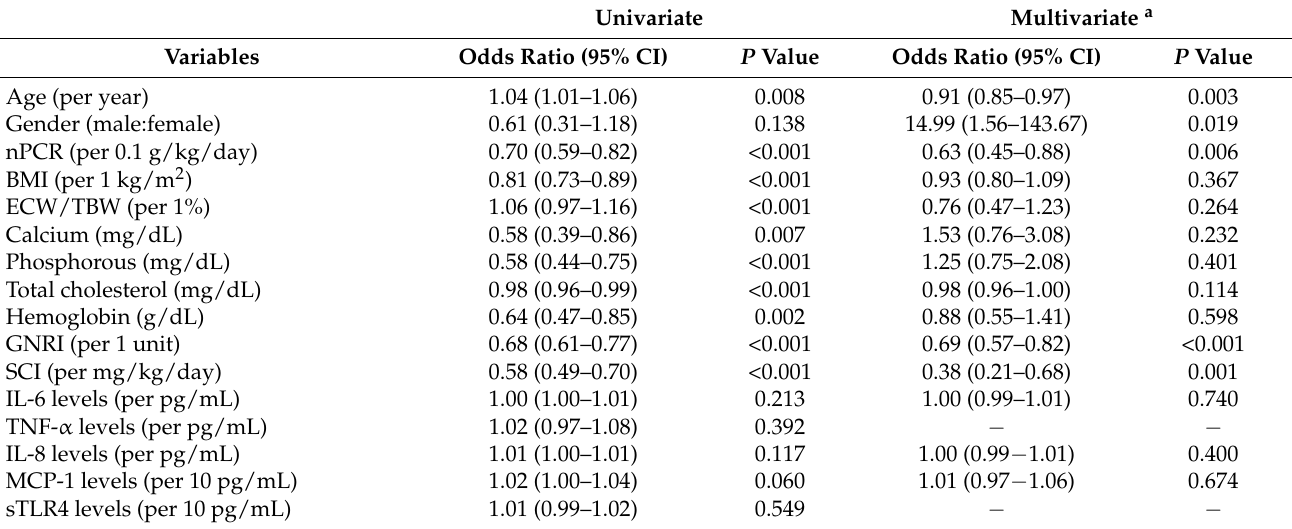
Table 5. Logistic regression analyses of potential factors associated with PEW status according to ISRNM criteria in patients undergoing